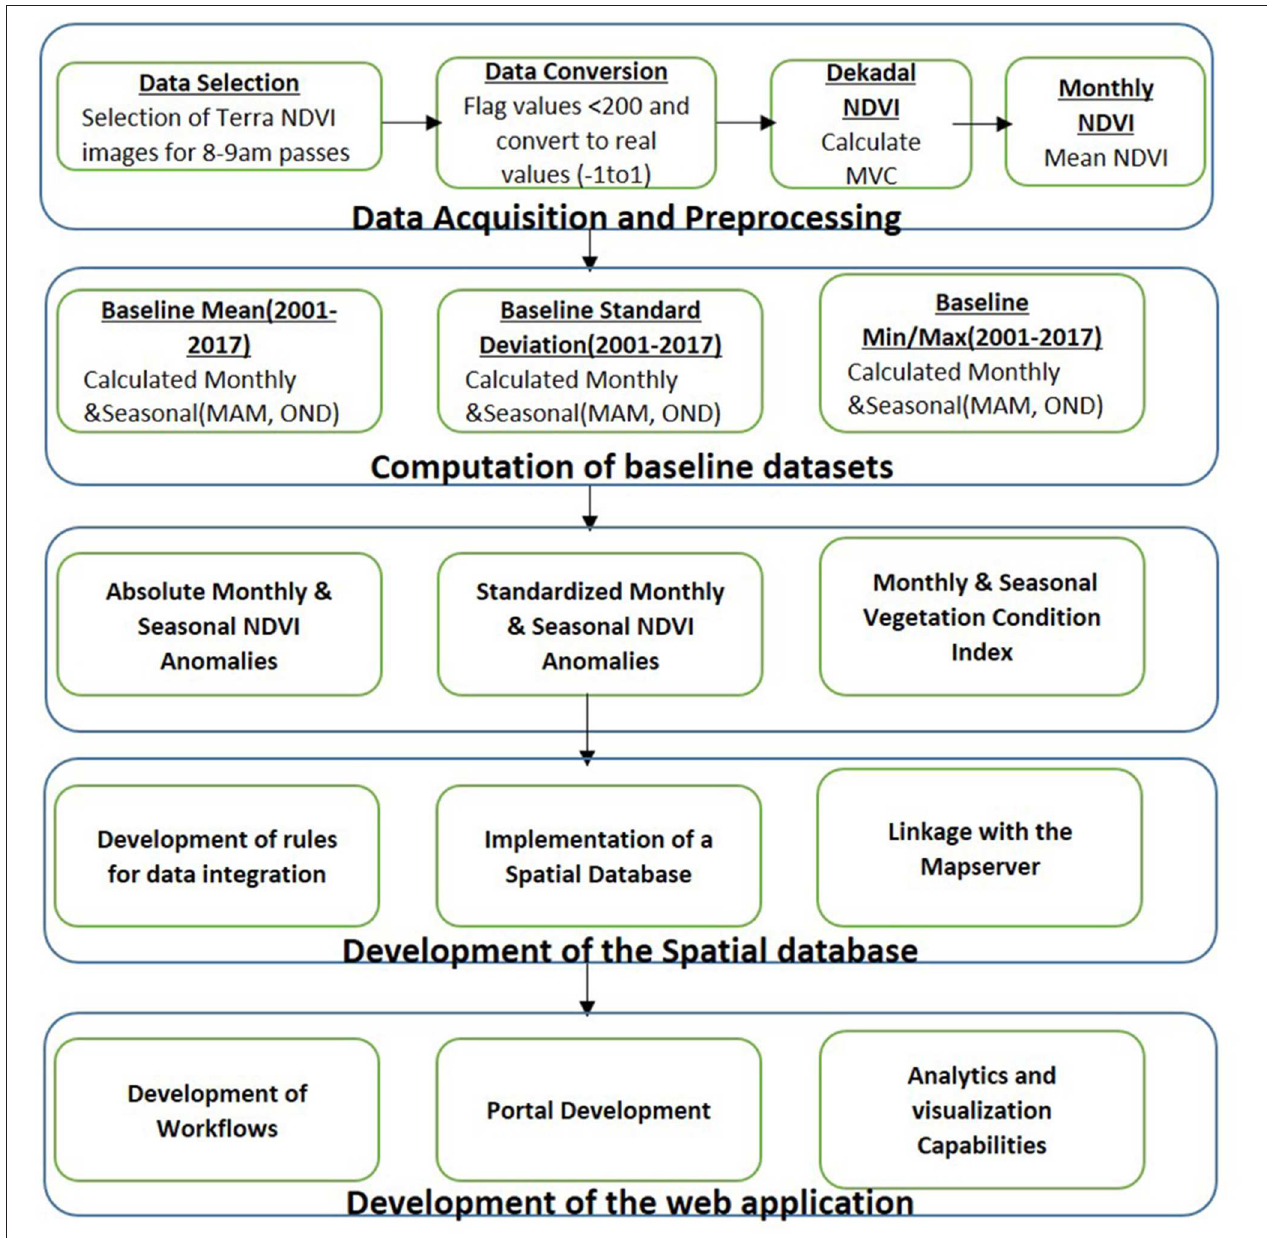
FIGURE 2 | Methodology workflow.